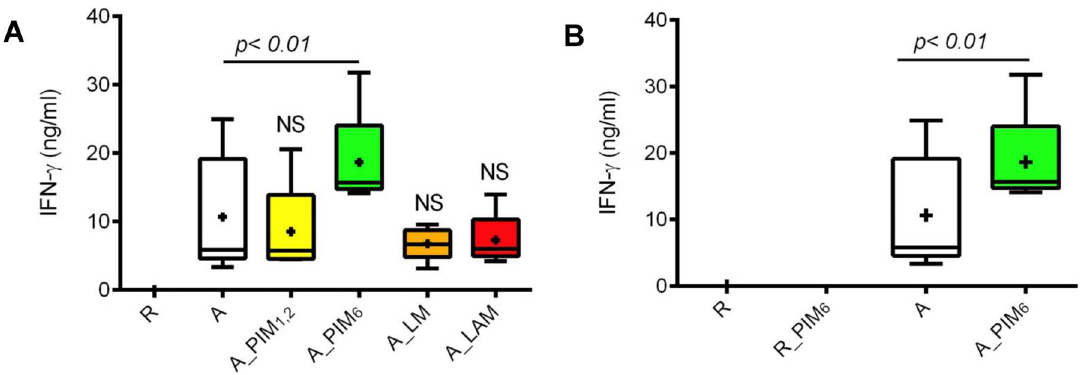
Figure 3. IFN- c in culture supernatants of activated CD4 + T cells in presence of MTB glycolipids. (A) CD4 + T cells were left unstimulated (resting, R) or were activated with a -CD3, a -CD28/CD49d and IL-2 for 48 h in medium alone (A) or medium containing mycobacterial glycolipids (A_PIM 1,2 , A_PIM 6 , A_LM, A_LAM). (B) CD4 + T cells were left unstimulated in medium alone (R) or medium containing PIM 6 (R_PIM 6 ) or were activated with a -CD3, a -CD28/CD49d and IL-2 for 48 h in medium alone (A) or medium containing PIM 6 (A_PIM 6 ). IFN- c in culture supernatants was measured by ELISA. Shown are means (crosses), medians (horizontal lines inside the box), first and third quartiles (lower and upper lines of the boxes) and the maximum and minimum values (upper and lower whiskers) from five independent experiments with different donors.